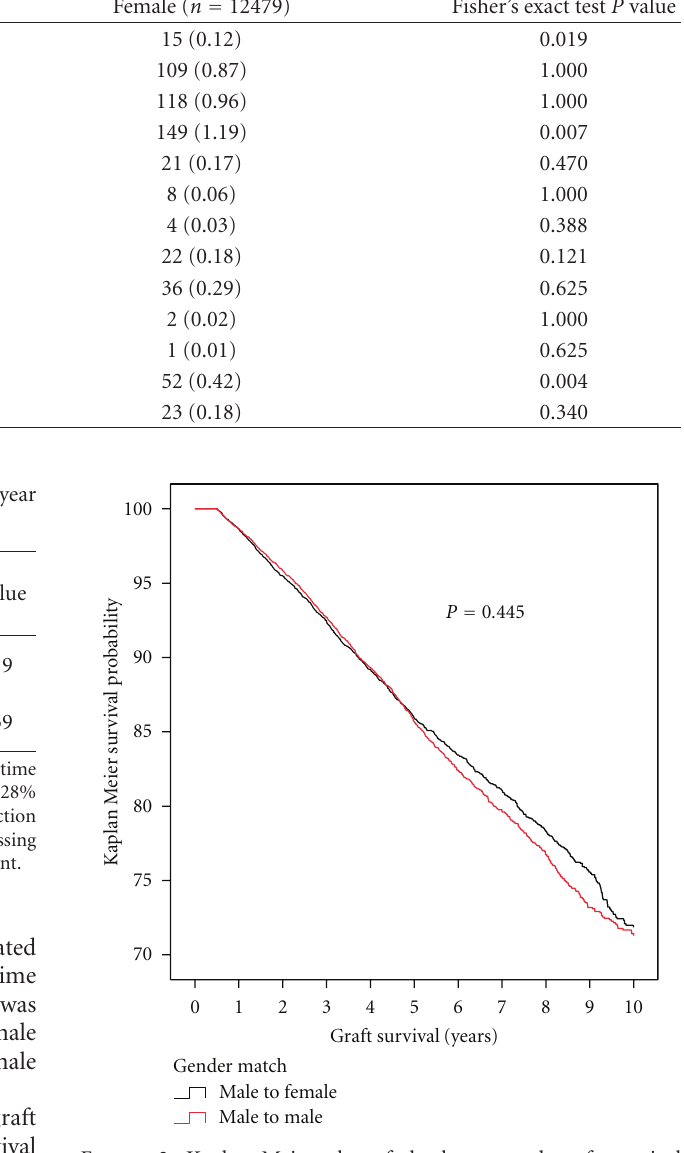
Figure 2: Kaplan Meier plot of death censored graft survival between six months and ten years post kidney transplantation. Black line is female recipients of male donor kidneys and the red line is male recipients of male donor kidneys. Note y -axis begins at 100% and ends at